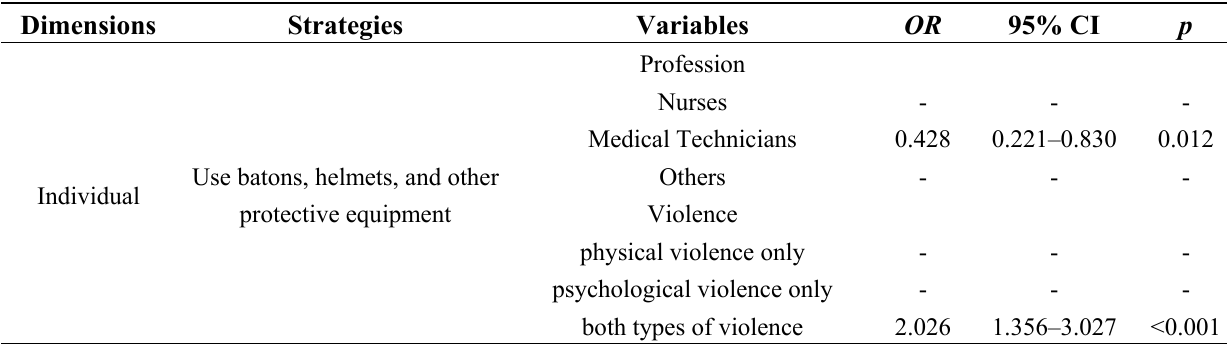
Table 4. Multiple logistic regression of the factors influencing workers’ choices of strategies to prevent workplace